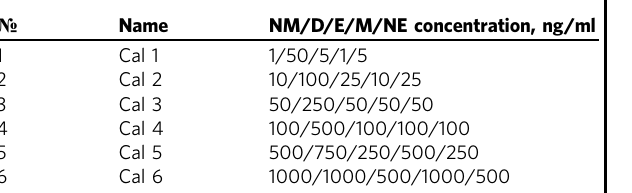
Table 1 Composition of calibration standards.